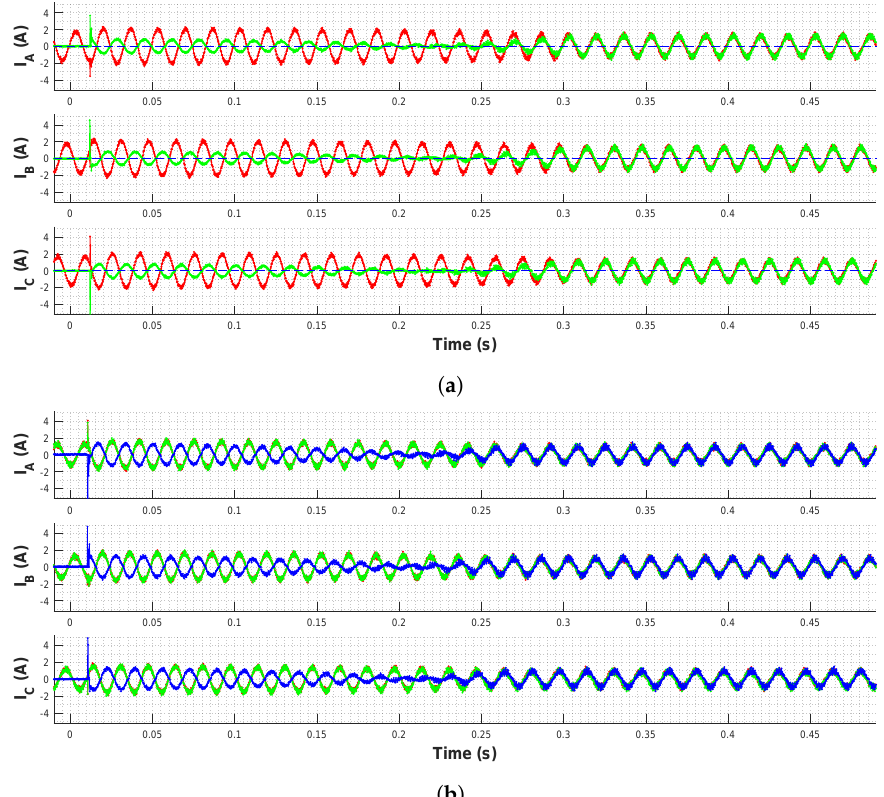
Figure 13. Experimental testing of current-controlled converter synchronization with DZO control. ( a ) One current-controlled inverter synchronizes when connected to another inverter operating at rated power. ( b ) Current-controlled inverter synchronizes when connected to two already-synchronized inverters. Three traces are shown (red, green, blue), but the red trace is directly under the green because they are already synchronized. A maximum load phase current of 4.64 A and a maximum inverter phase current of 8.48 A were observed in testing